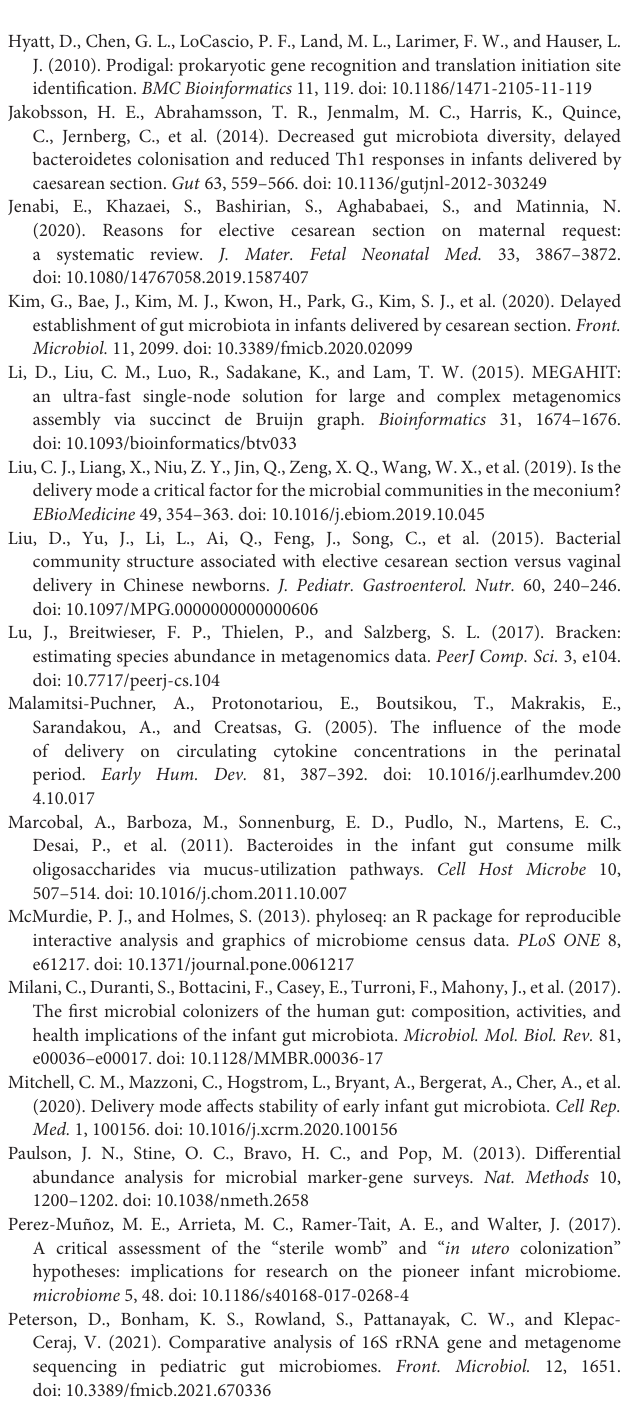
Supplementary Figure 3 | Bacterial diversity transition in ECS and VD newborns. Nonmetric Multidimensional Scaling (NMDS) ordination plot based on the relative abundance of taxa in VD (A) and ECS (B) . Supplementary Figure 4 | Relative abundance of ESKAPE members in ECS and VD newborns at each collection time point. Significance in the differences between groups was determined using the Mann–Whitney U